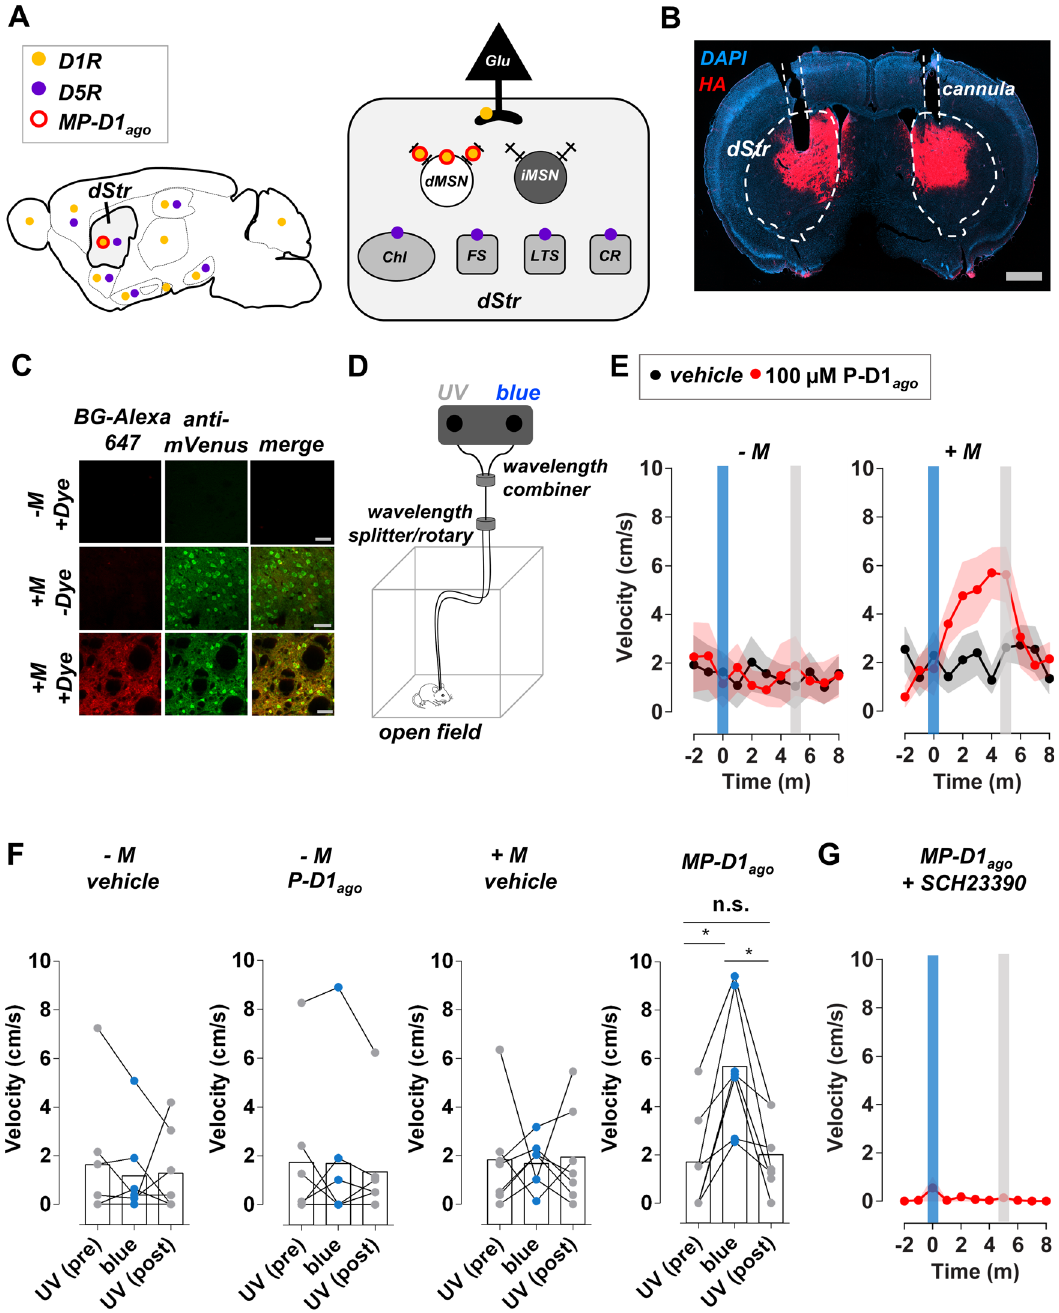
agonist SKF82958, which is expected to also activate D5R in multiple cell types. Like MP-D1 ago , SKF82958 enhanced loco- motion (Supplementary Fig. 19b – c). However, locomotion increased ~12-times faster with MP-D1 ago than with SKF82958 (Supplementary Fig. 19d), re fl ecting the temporal difference between light propagation (fast) and pharmacologic diffusion (slow) in brain tissue. Moreover, although both increased the percentage of the time that the mice were in motion (Supple- mentary Fig. 19e, f), MP-D1 ago selectively increased the prob- ability of movement initiation (Fig. 4), whereas SKF82958 increased both movement initiation and the duration of the movement bouts (Supplementary Fig. 19g, h). This difference indicates that locally infused DAR ligands may not faithfully mimic the actions of dopaminergic input, either because